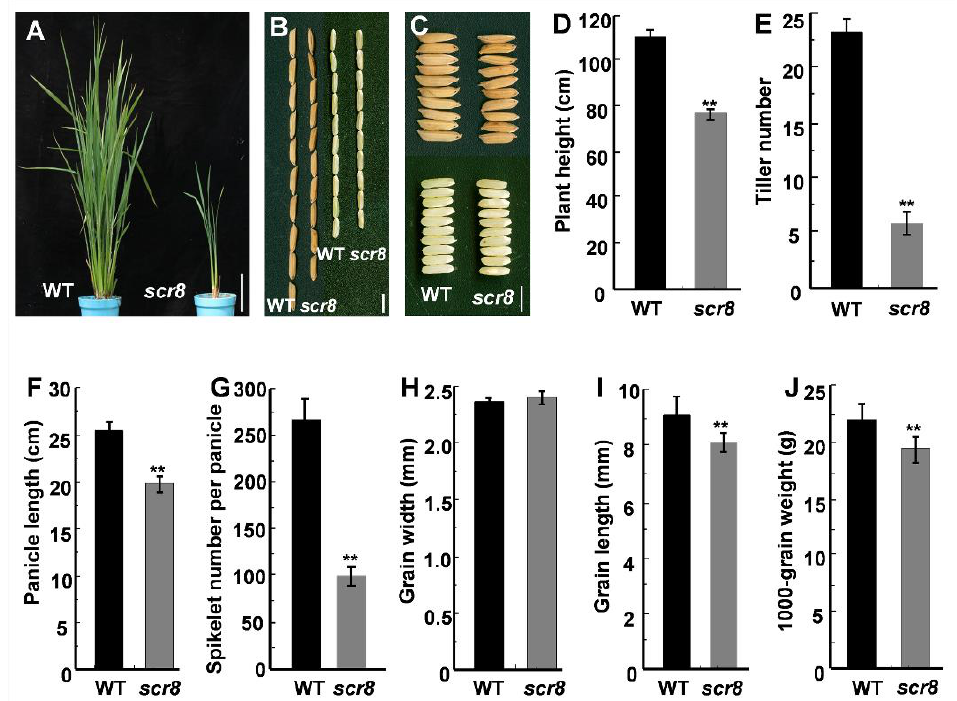
Figure 1. Characterization of WT and scr8 mutant. ( A ) Plant architecture of WT and scr8 mutant plants at the booting stage. Scale bars, 10 cm. ( B , C ) Mature paddy rice grains and brown rice grains from WT and scr8 . Scale bars, 0.5 cm. ( D – J ) Comparisons between WT and scr8 for average plant height (n = 15 plants) ( D ), average tiller number (n = 15 plants) ( E ), average panicle length (n = 15 plants) ( F ), average spikelet number per panicle (n = 15 plants) ( G ), average grain width (n = 15 plants) ( H ), average grain length (n = 15 plants) ( I ), 1000-grain weight (n = 15 plants) ( J ). Error bars represent standard deviation (SD). ** Significant difference at p < 0.01 compared with the WT by Student’s t -test.